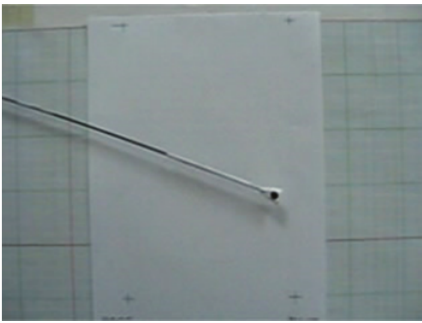
Figure 10: Recording the backbone’s motion for further image processing and